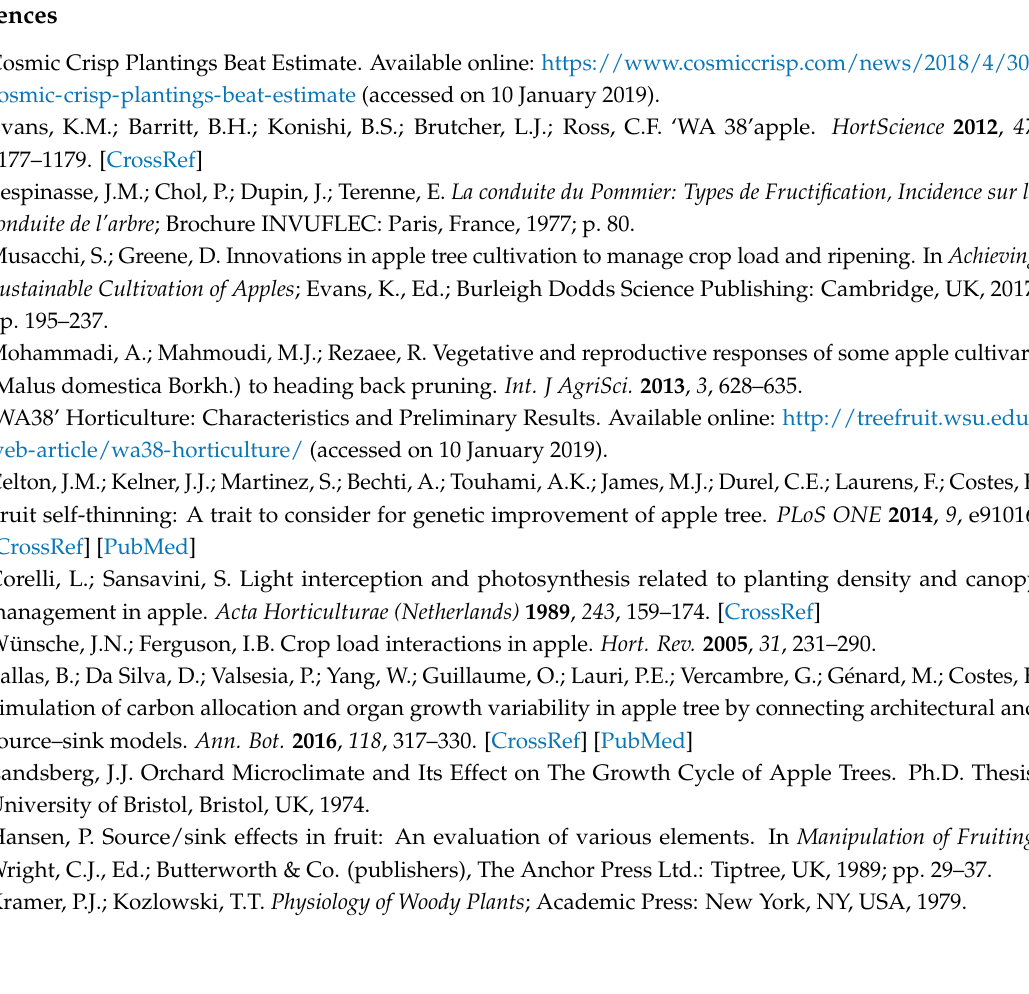
Table S1: The effects of crop load on leaf SPAD units, and fruit hue and chroma from the Minolta color meter from “WA38” apple trees grown in Rock Island, Washington in 2017; Table S2: The effect of crop load on the biennial index and classification as assessed by Hoblyn et al. [69] for “WA38” trees grown in Rock Island, Washington across 2017–2018. Biennial index ratings assessed by fruit number/tree; Figure S1: The effect of crop load on fruit size and red coloration of fruit positioned on their sun exposed side (the darkest part of the apple) from “WA38” apple trees adjusted to various crop loads grown in Rock Island, Washington in 2017; Figure S2: Average flower bud count on experimental trees in the spring of 2018 (sixth leaf) and their position (terminal on “brindilla”/“ramo misto”, lateral on “ramo misto”, and spur/central axis) on “WA38” trees grown in Rock Island,